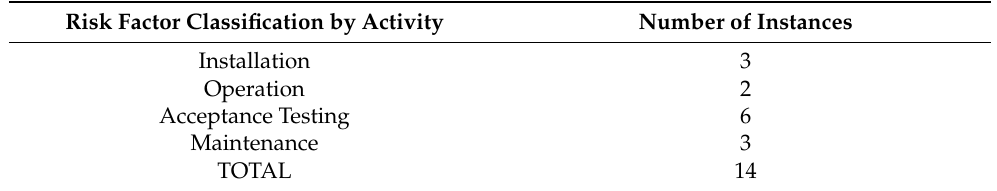
Table 5. Risk factors in Operation and maintenance